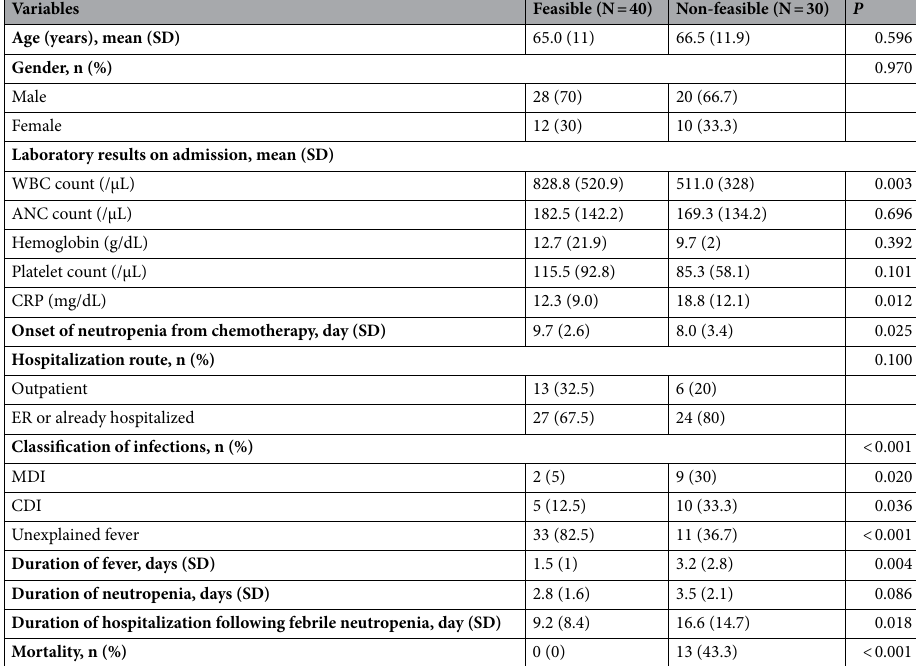
Table 3. Comparisons of significant variables between feasible and non-feasible outpatient management group among patients in the high-risk group. SD standard deviation, WBC white blood cell, ANC absolute neutrophil count, CRP C-reactive protein, MASCC Multinational Association of Supportive Care in Cancer, CISNE Clinical Index of Stable Febrile Neutropenia, ER emergency room, MDI microbiologically defined infection, CDI clinically defined